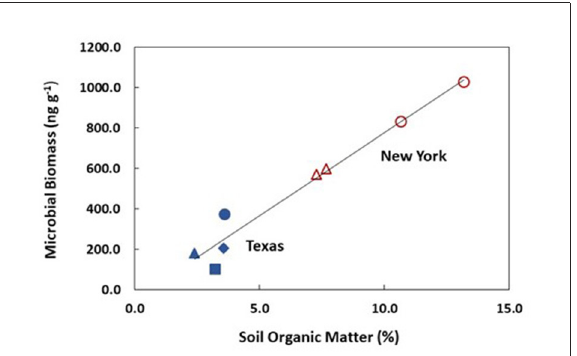
FIGURE1 Least squares regression model of microbial biomass (MB) on soil organic matter (SOM, %) in soils from pastures in upstate New York (red; Kleppel, 2019) and ranches or un-grazed grassland in Texas (blue; Teague et al., 2011). Open symbols indicate that SOM was estimated from the assumed linear relationship between MB and SOM (Batisda et al., 2021). Circles indicate that an RM grazing protocol was used. Triangles indicate continuous grazing, and a square indicates heavy continuous grazing (both are CM protocols). The diamond represents un-grazed